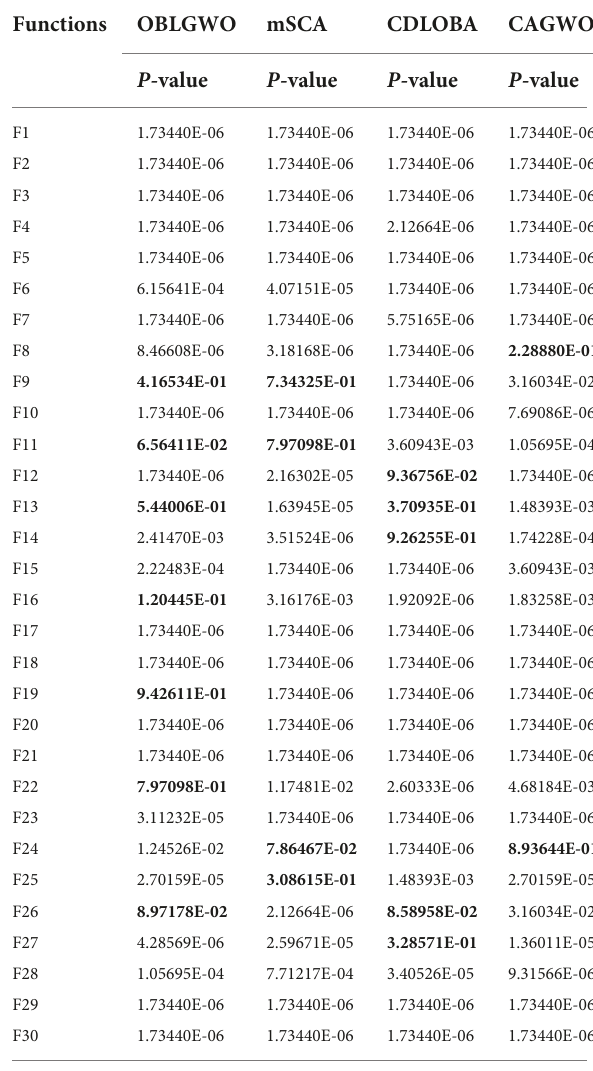
TABLE 11 Results of Wilcoxon signed-rank test.